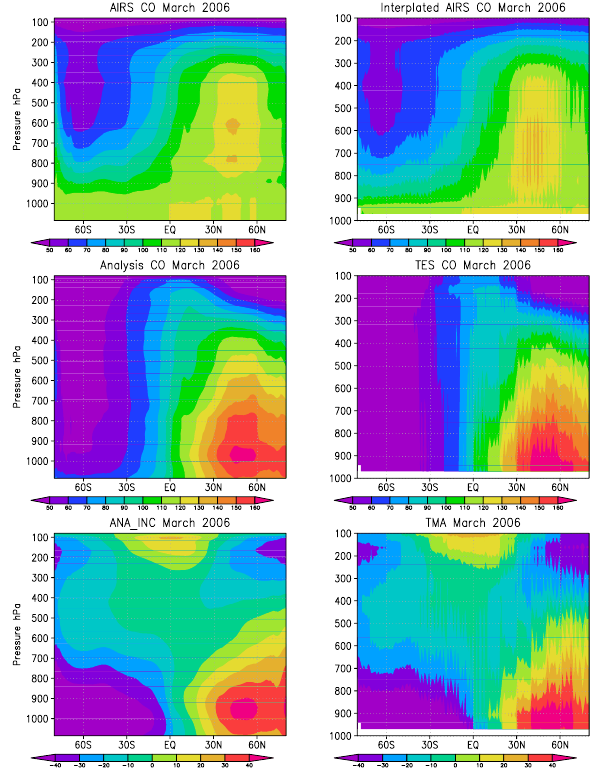
Fig. 5. Grid averaged monthly zonal means with AIRS CO (left top panel), analyzed CO (left middle panel), analysis increment (left bottom panel), AIRS CO interpolated to TES location (right top panel); TES CO (right middle panel); and OMF showing TES minus AIRS CO (right bottom panel).